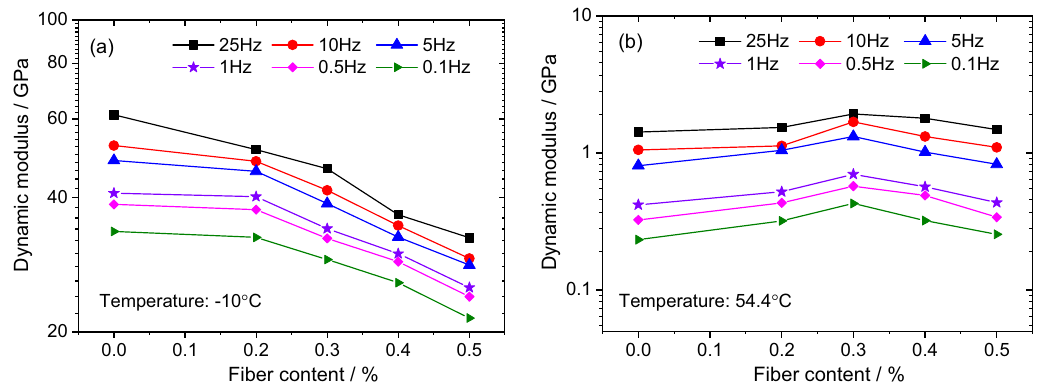
Figure 4: Variation of E ∣ ∣ ∗ basalt fi ber content at ( a ) − 10°C and ( b )